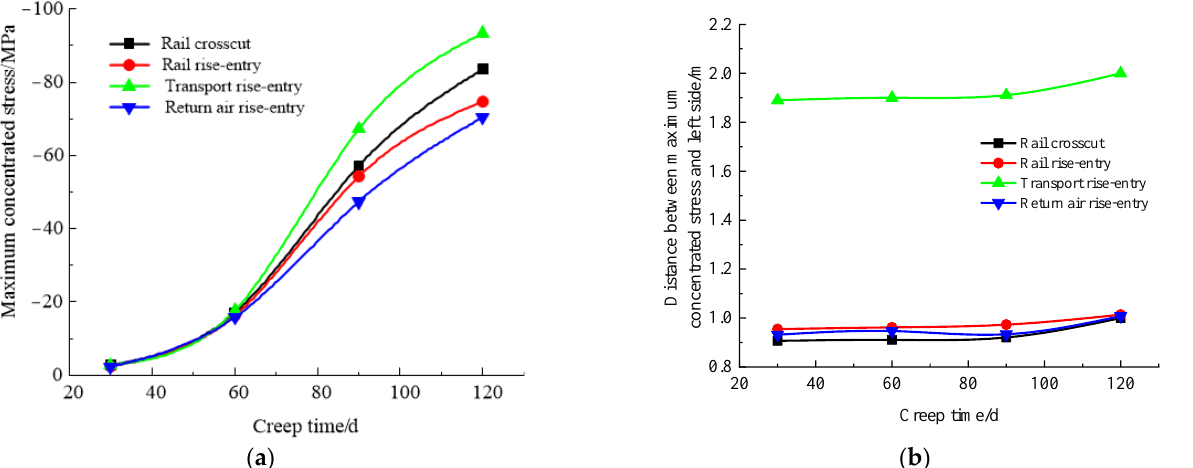
Figure 17. Maximum concentrated stress and its location monitoring results under different creep time conditions. ( a ) Maximum concentrated stress, ( b ) Position of maximum concentrated stress.